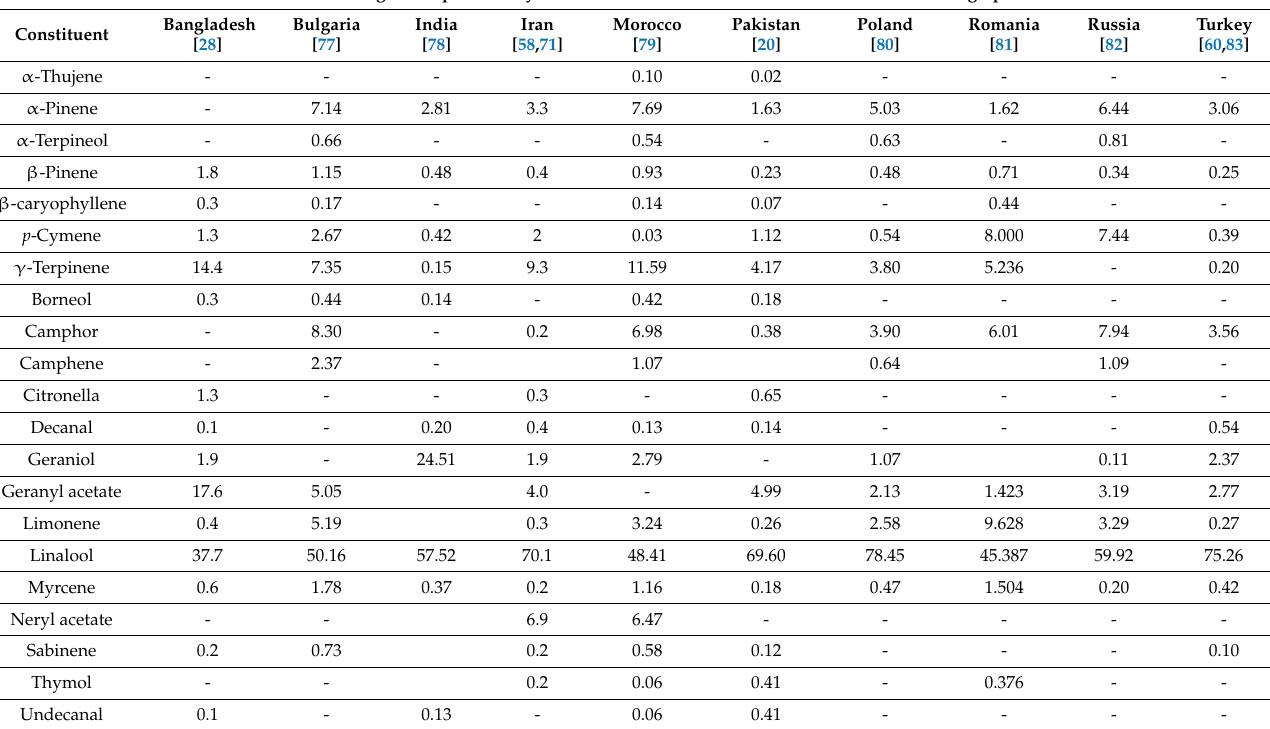
Table 4. Variation of some important phytochemicals in coriander seed EO across different geograph- ical